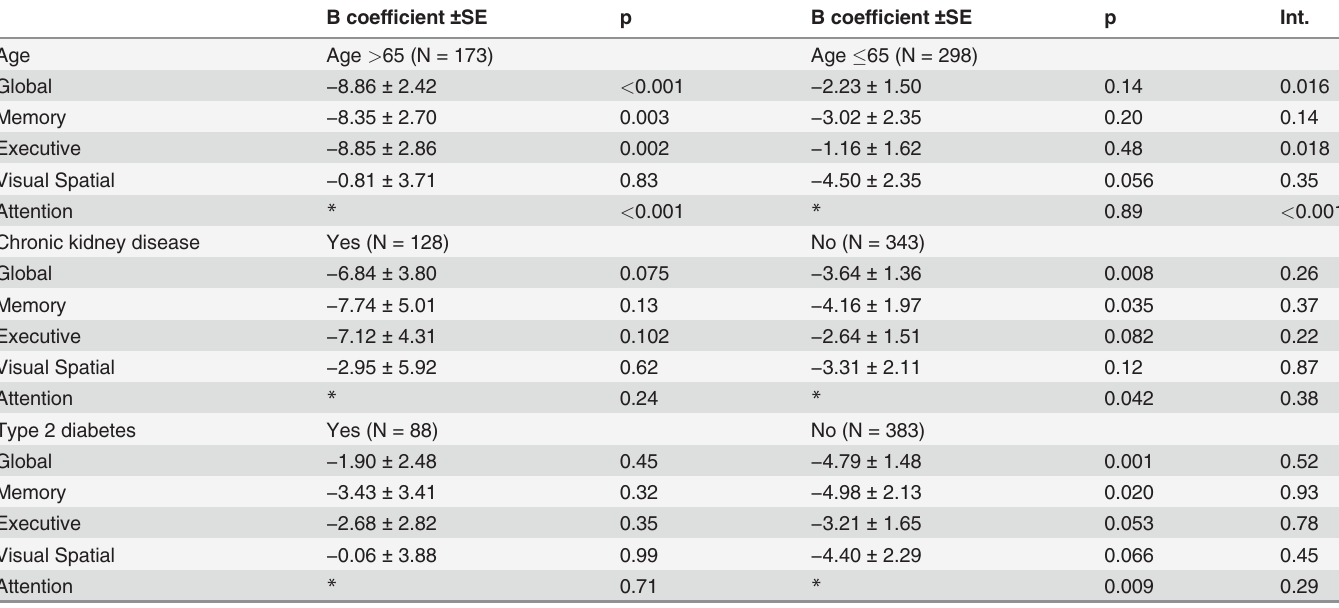
Table 3. Linear Regression Model of association between low UA (bottom quintile vs. higher) and cognitive performance for various